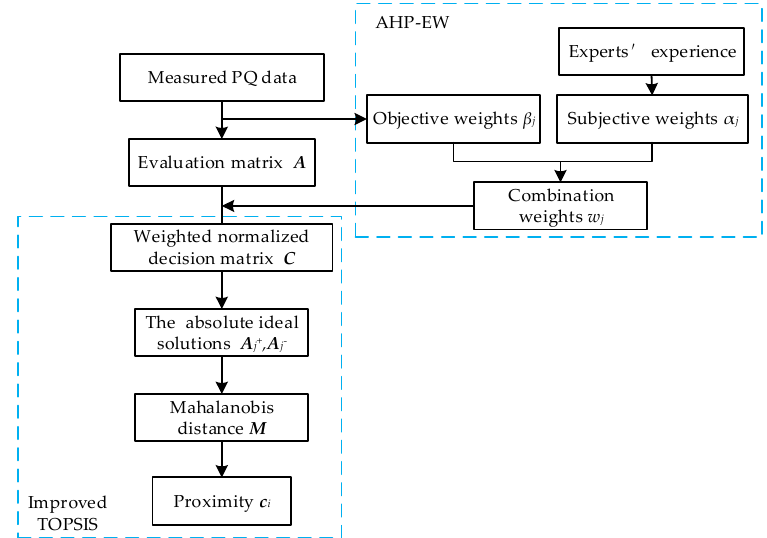
Figure 6. The flowchart of power quality (PQ) comprehensive evaluation based on the improved TOPSIS method.